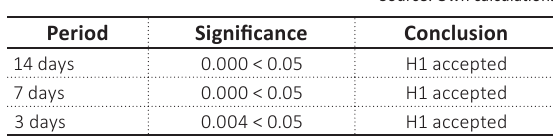
Table 4. Stock return difference test results